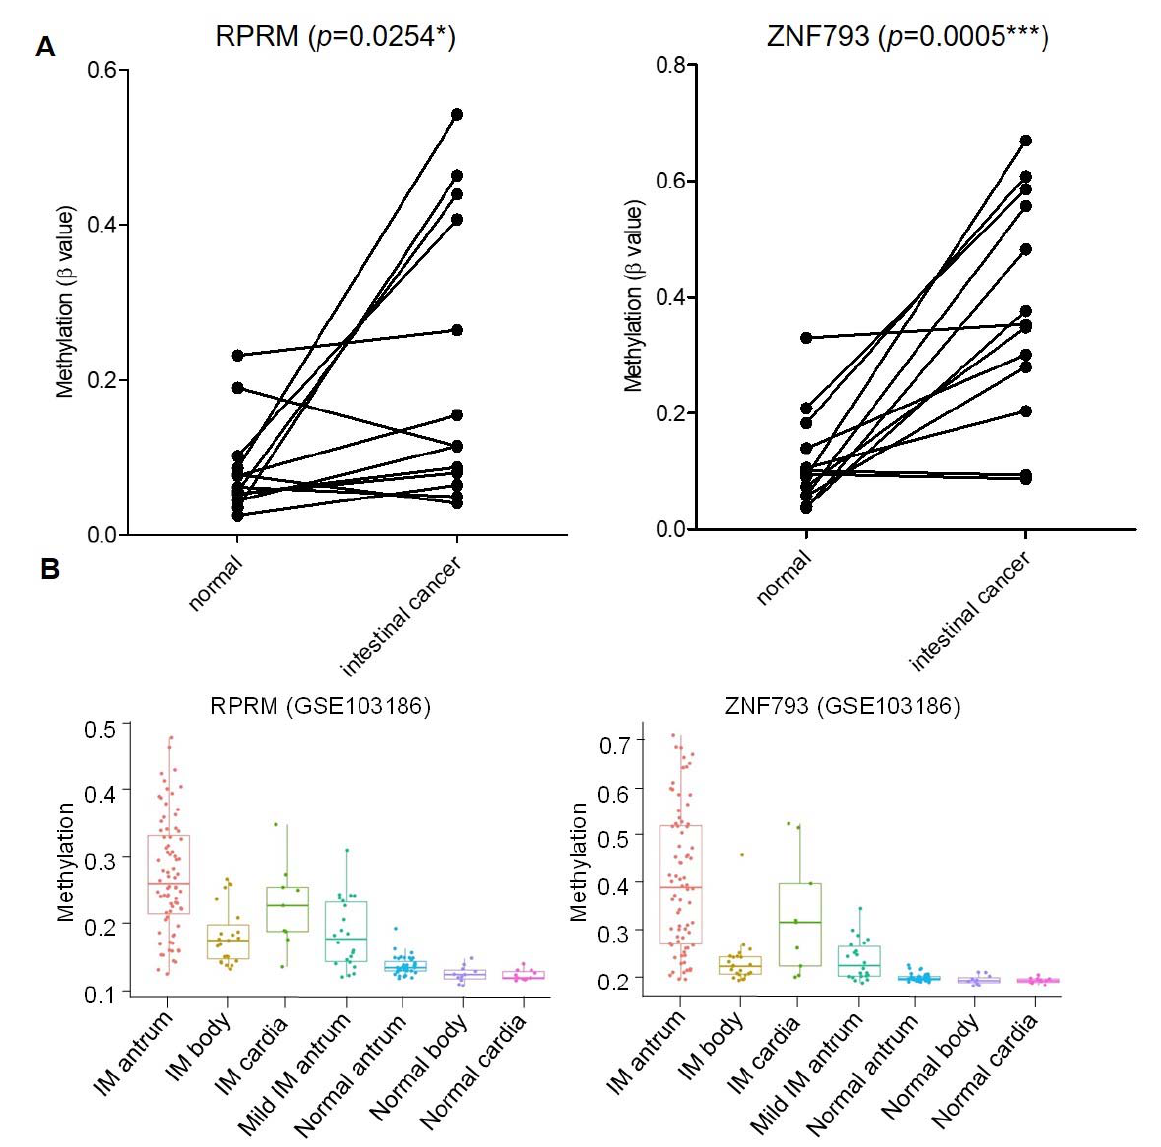
Figure 3. Methylation of ZNF793 and RPRM genes in intestinal type of gastric cancer and precursor lesions. ( A ) Methylation level of ZNF793 and RPRM genes in intestinal type of gastric cancer. Values from 13 adjacent-non-tumoral samples paired with the tumor sample are shown. Methylation values represent the average of β -value obtained for the three CG probes in the methylation array (paired t -test, two-tailed, p < 0.05, * p -value ≤ 0.05, *** p -value ≤ 0.001). ( B ) CpG methylation at RPRM and ZNF793 promoter in three anatomic intestinal regions (antrum, cardia and body) of intestinal metaplasia patients and normal mucosae (available data from GSE103186).